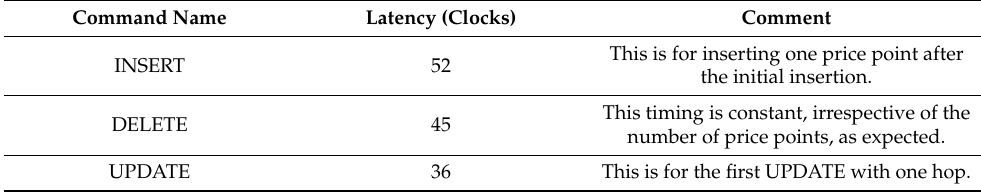
Table 3. Latencies of various commands.